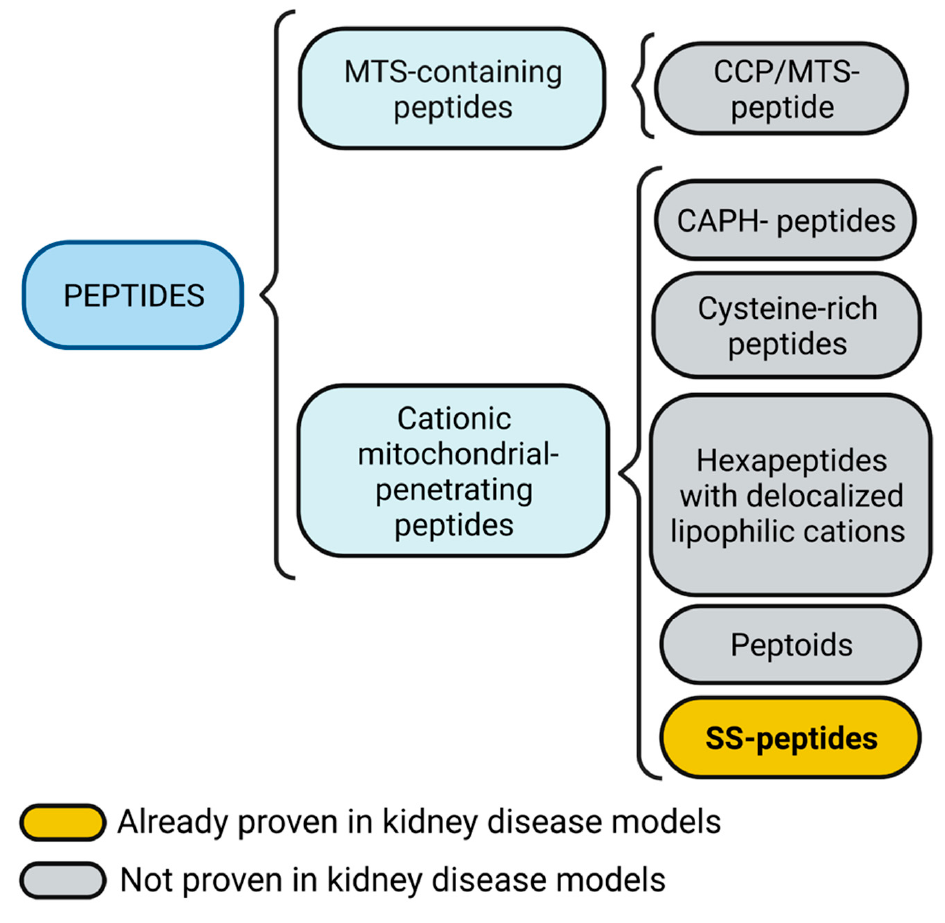
Figure 3. Mitochondria targeting peptides. Mitochondria targeting sequence (MTS)-containing pep- tides also could include a cell-penetrating peptide (CPP) feature. Cationic mitochondrial penetrating peptides could be subdivided into cationic amphiphilic polyproline helix (CAPH) peptides, cysteine- rich peptides, and hexapeptides with delocalized lipophilic cations, peptoids, and Szeto-Schiller (SS) peptides. Figure created with BioRender.com.